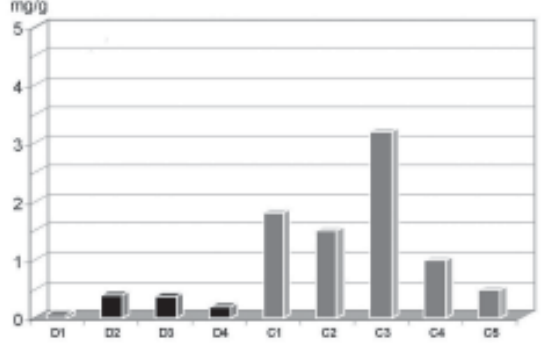
Fig. 5 - Quantificação de cálcio nos condutos dos Heteroenxertos Descelularizados (D) e Homoenxertos Criopreservado (C). Demonstração gráfica do conteúdo de cálcio dos condutos das valvas do Grupo Crio (C) e Grupo Desc (D), P=0,014